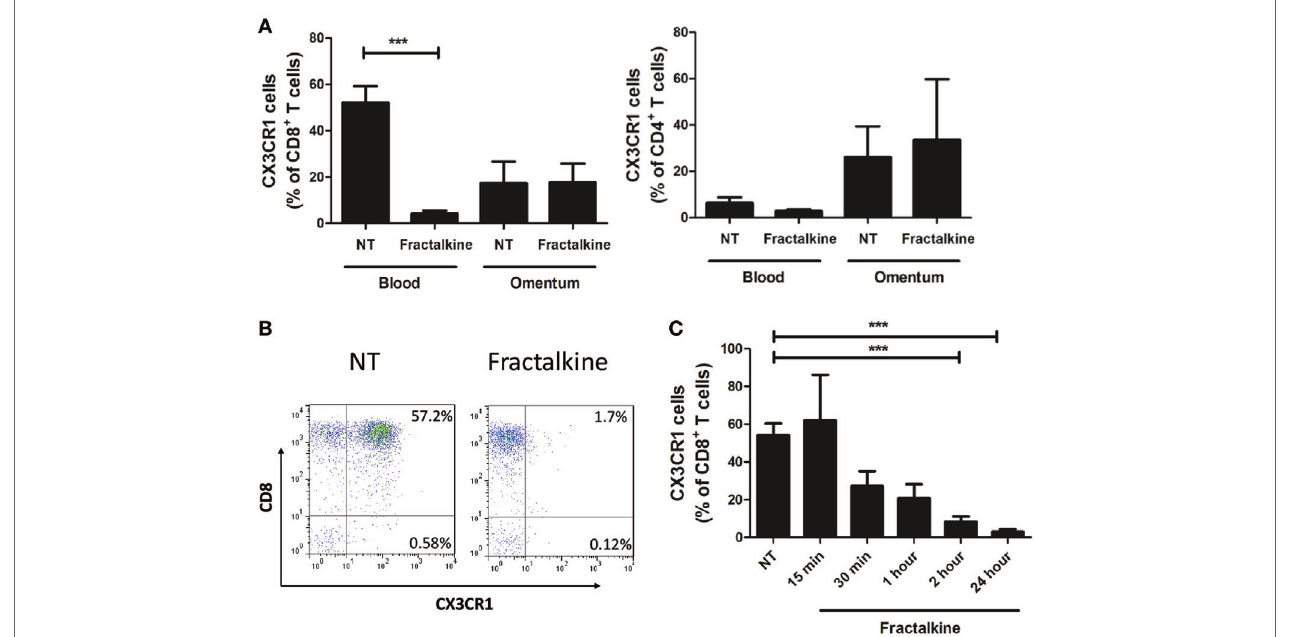
FigUre 3 | Peripheral blood CD8 + T cells exhibit a significant and sustained reduction in CX3CR1 surface expression following treatment with recombinant fractalkine. (a) Frequencies of CX3CR1 + cells, as a percentage of CD8 + T cells (left) and CD4 + T cells (right) following; treatment with M199 media alone (NT) or 30 ng/ml of recombinant fractalkine for 2 h ( n = 17); (B) representative dot plots of CX3CR1 expression following treatment with M199 media alone (NT) or 30 ng/ml of recombinant fractalkine for 2 h. (c) Frequencies of CX3CR1 + cells, as a percentage of CD8 + T cells following treatment with M199 media alone (NT) or 30